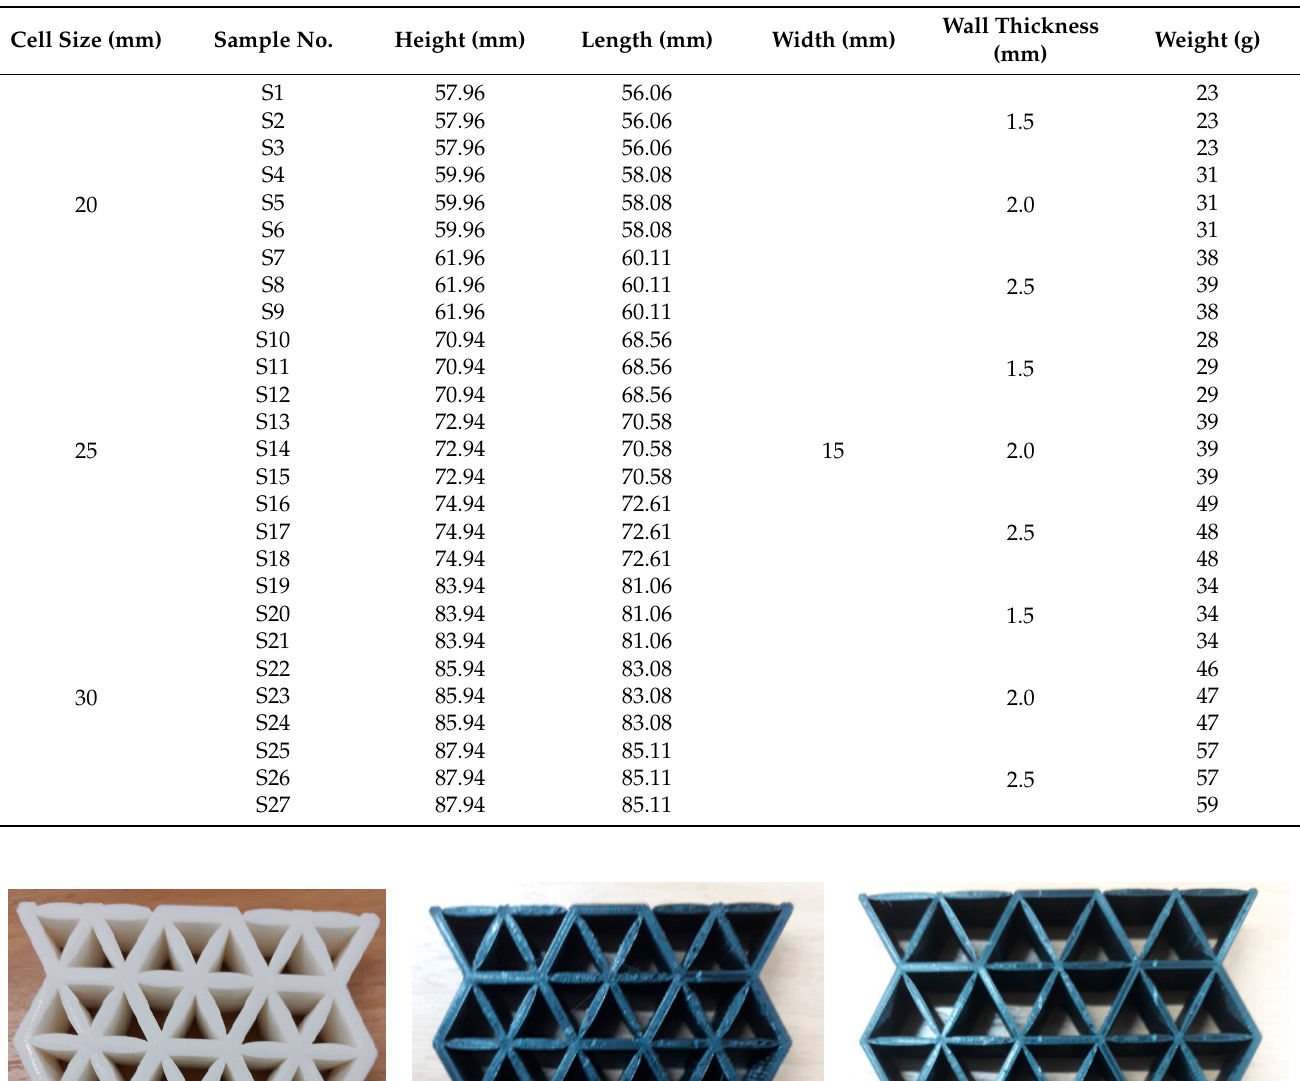
Table 1. Physical properties of the 3D printed samples.